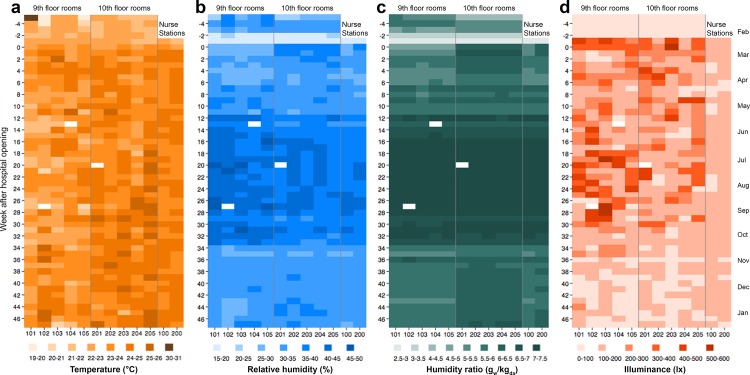
Weekly averages of environmental conditions in the patient rooms and nurse stations measured over the duration of the project: (a) temperature, (b) relative humidity, (c) humidity ratio, and (d) illuminance.Rooms 101–105 are on the 9th floor; rooms 201–205 are on the 10th floor. Room 100 and 200 are the nurse station locations on the 9th and 10th floor, respectively. Weeks are counted from the week of hospital opening (i.e., week 0). White areas represent missing values. Values along the x-axes correspond to room identification numbers. Examples time series data at 5-min intervals for one day are shown in S5 Fig.